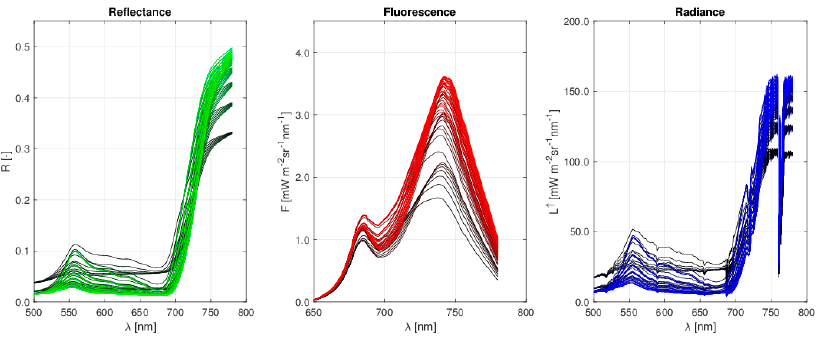
Figure 5. Surface reflectance ( left ), sun-induced fluorescence ( middle ), upwelling radiance ( right ) simulated for the different RT simulations.